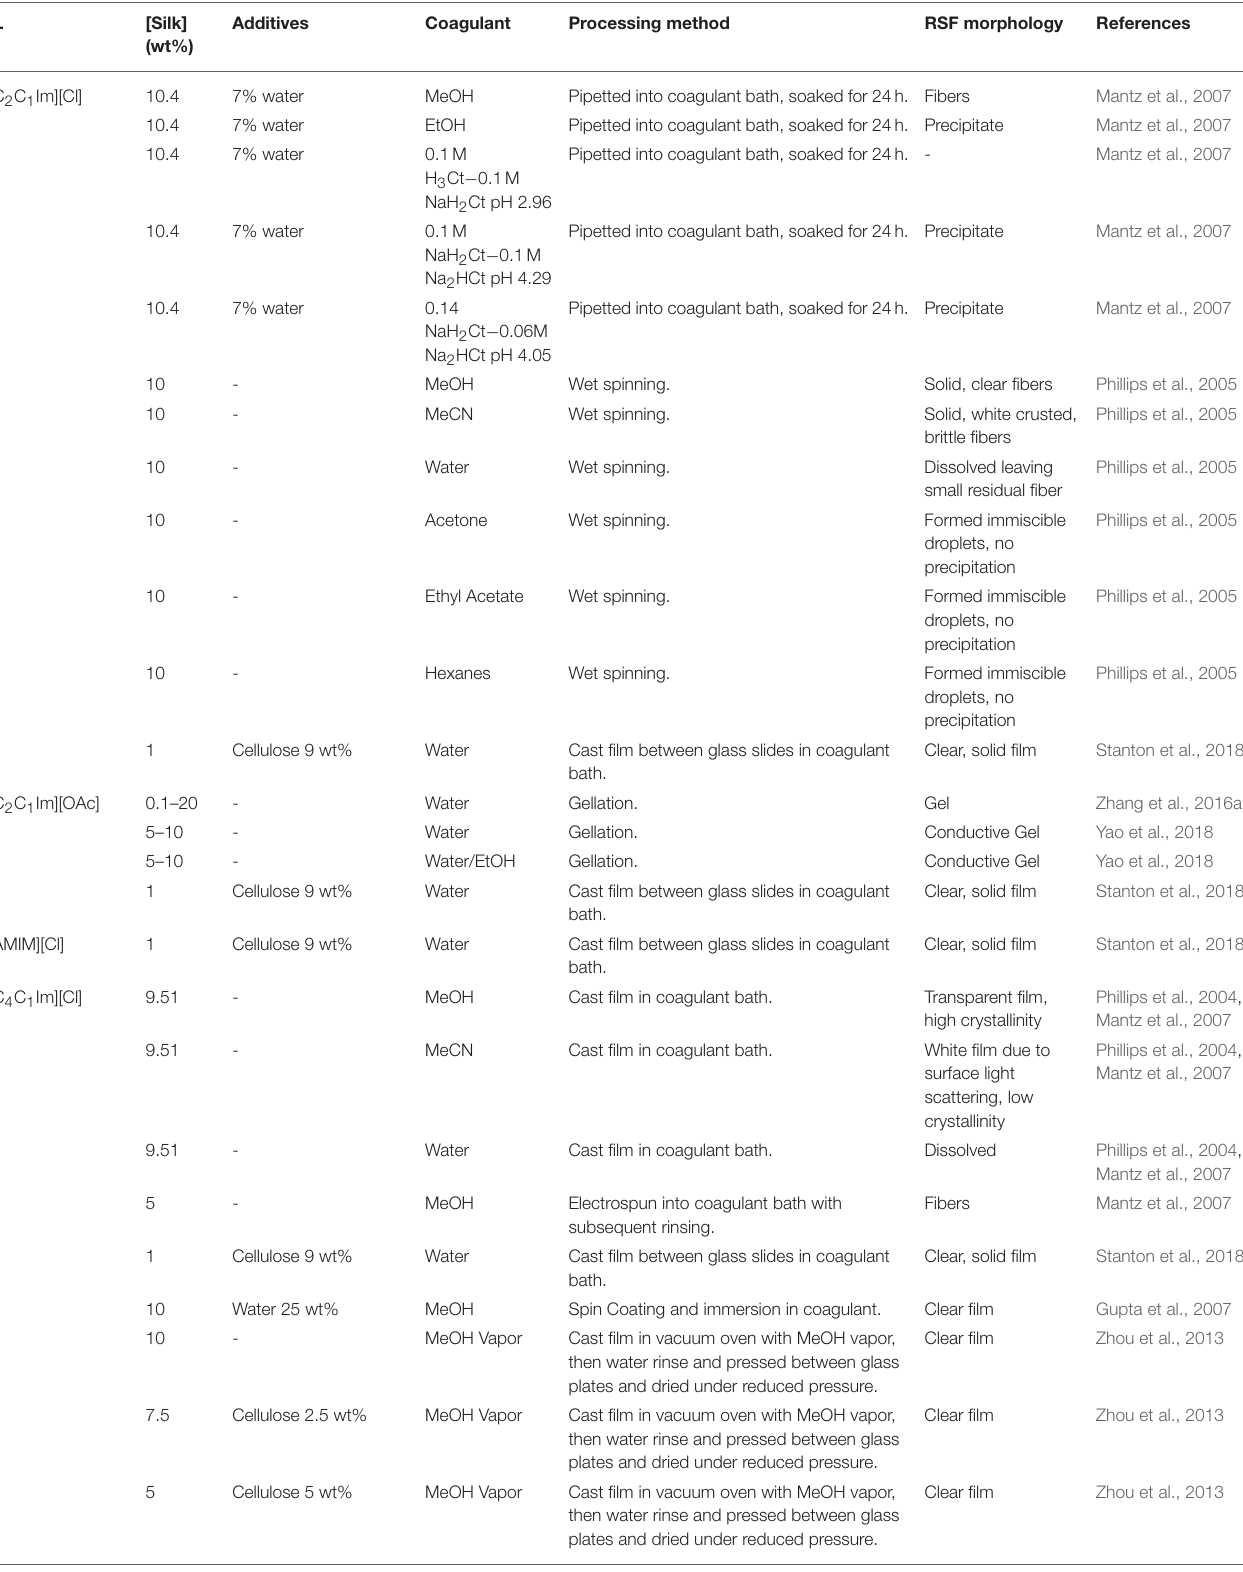
TABLE 3 | A representative sample of methods by which silk is dissolved and subsequently reformed listing silk concentrations, additives, coagulants and processing methods.